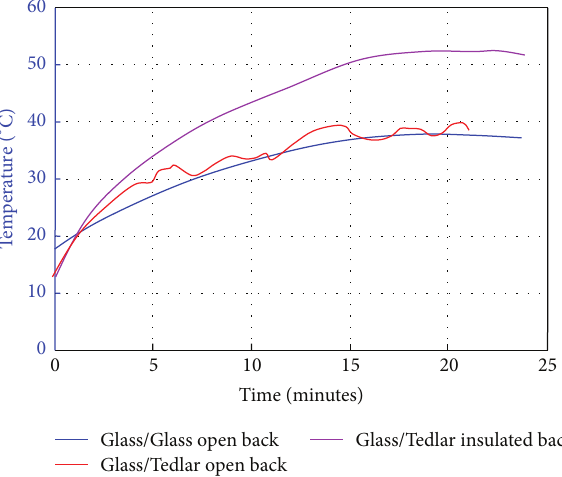
Figure 2: Transient of three PV modules as shown in